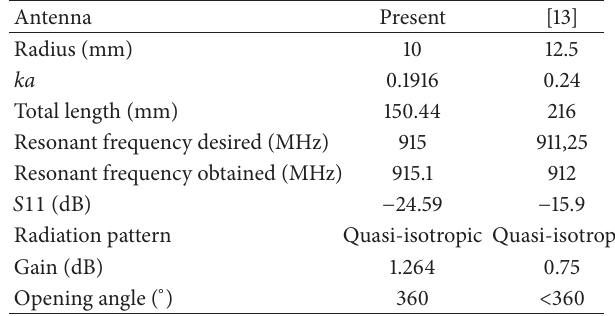
Table 12: Comparison between this work and the previous work